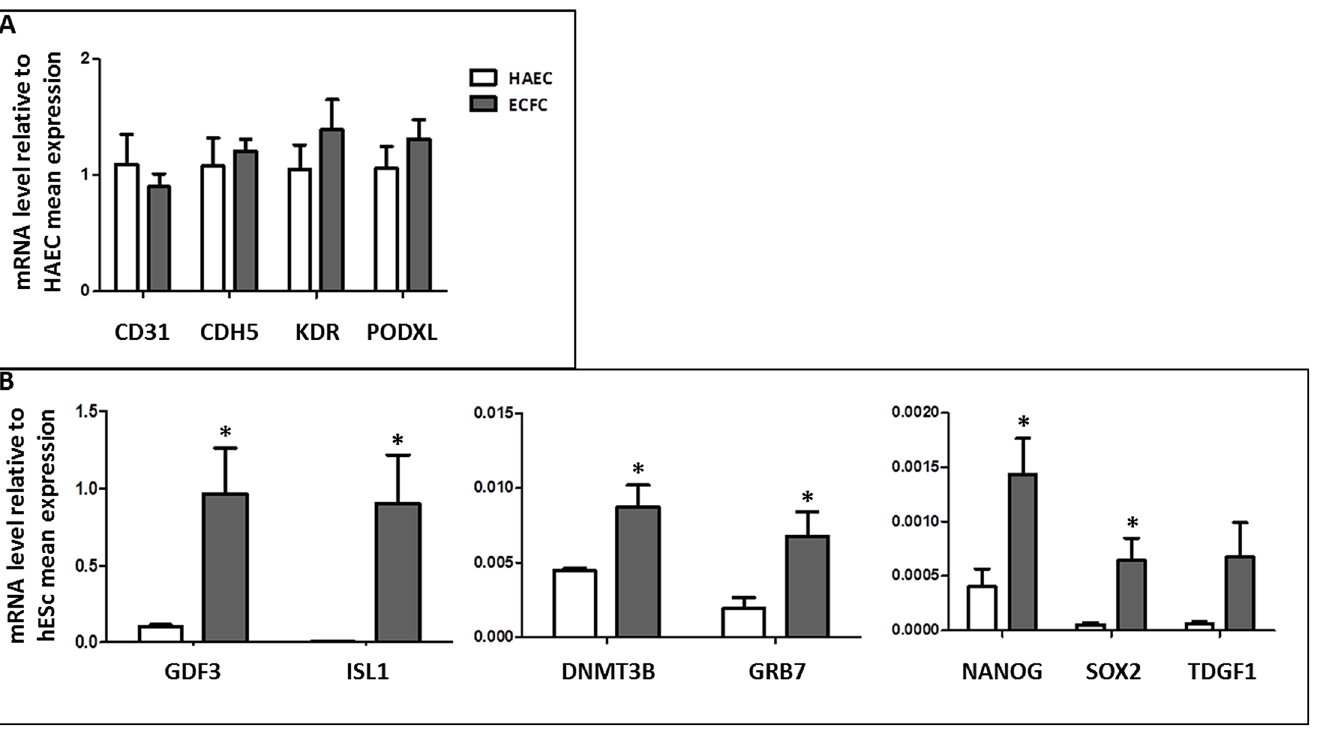
Fig 6. Endothelial and Stemness transcriptional signature of CB-ECFCs. (A) Transcript levels of endothelial markers. Quantitative RT-PCR analysis in ECFCs at passage P1 (n = 6) and adult HAECs at passage P3 (n = 4). Transcript levels were normalized to GAPDH transcript levels and relative to mean HAECs. (B) Transcript levels of stemness markers. Quantitative RT-PCR analysis in ECFCs at passage P1 (n = 6) and adult HAECs at passage P3 (n = 4). Transcript levels were normalized to GAPDH transcript levels and relative to mean hESCs (2 H9 samples at P45 and P52 and 1 H1 sample at P54). Error bars represent SEM ( * p <